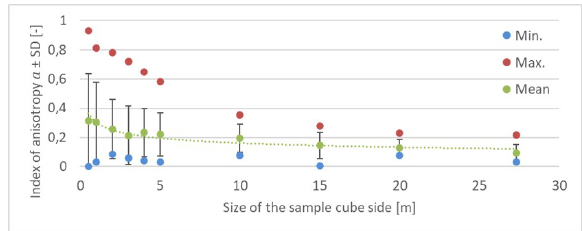
Figure 5. Sample size dependence of the index of anisotropy α